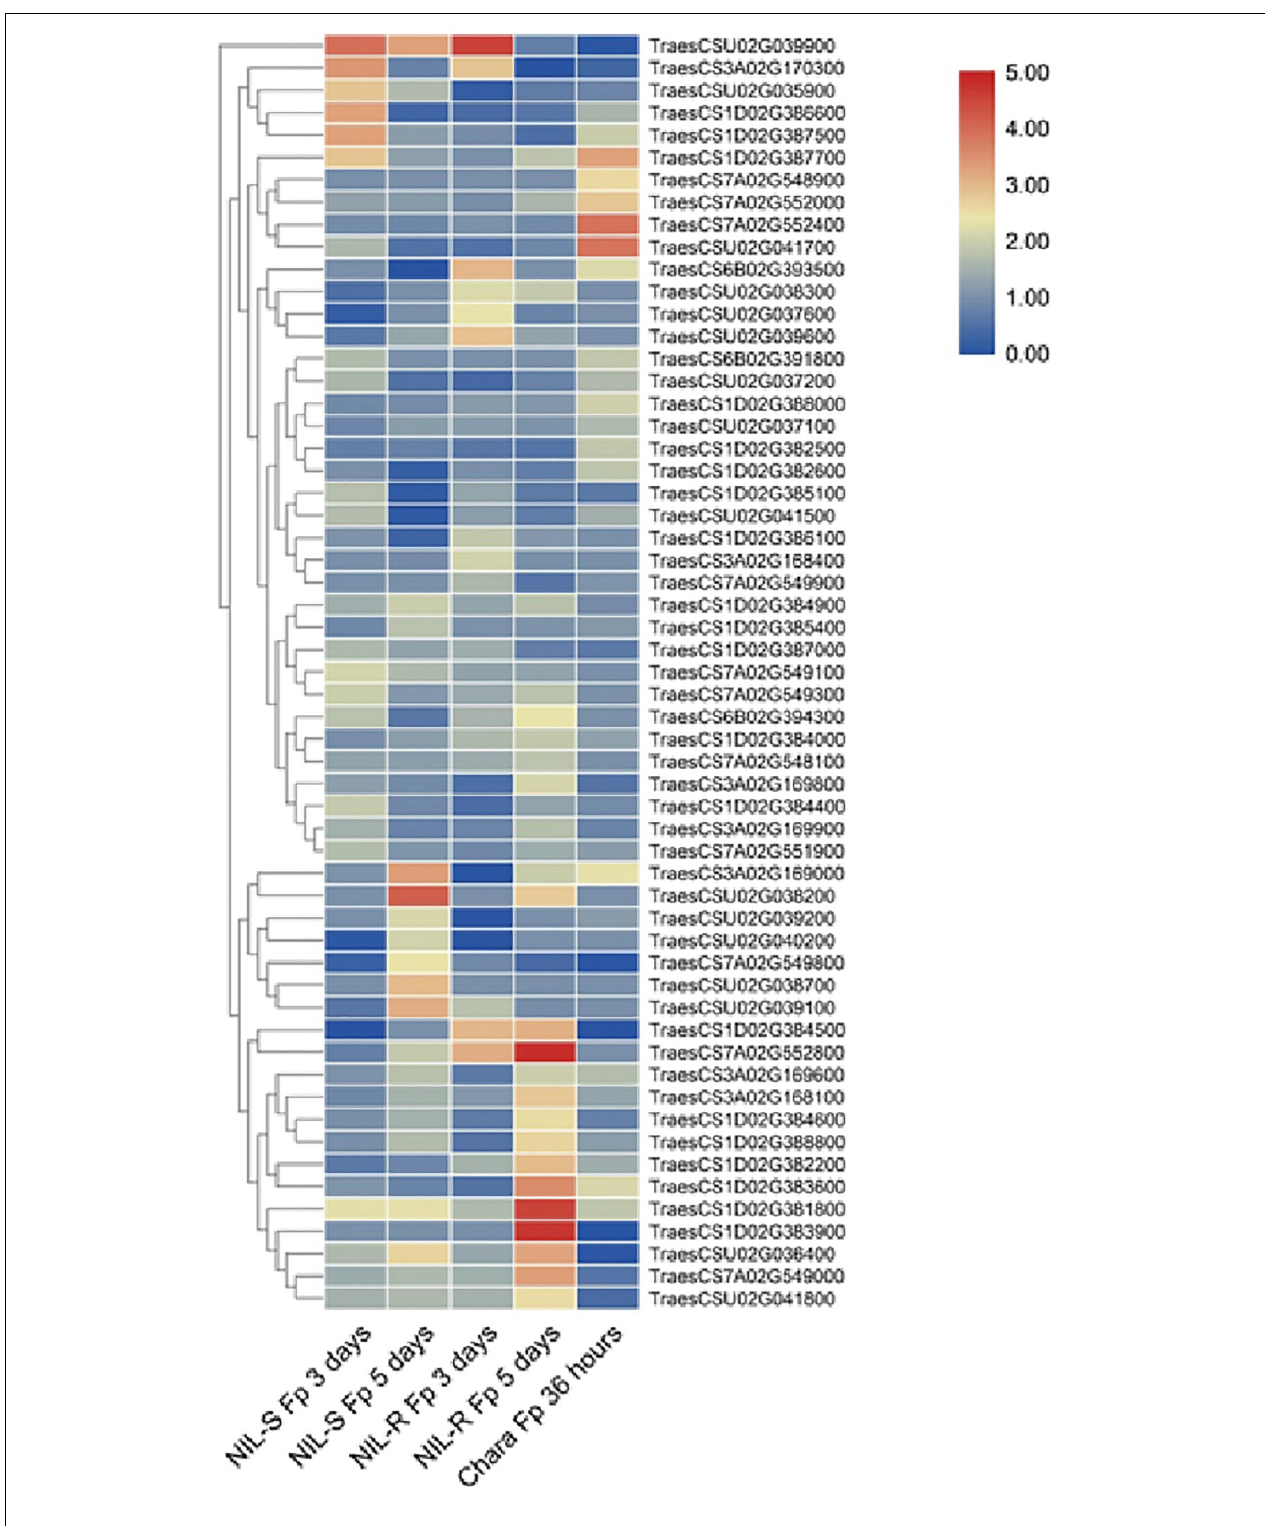
FIGURE 4 | Clustering heatmap for differentially expressed genes infected by Fusarium spp. compared to those in the mock. S-NIL1-Fp 3 days, susceptible isolines infected by Fusarium spp. after 3 days; S-NIL1-Fp 5 days, susceptible isolines infected by Fusarium spp. after 5 days; R-NIL1-Fp 3 days, resistant isolines infected by Fusarium spp. after 3 days; R-NIL1-Fp 5 days, resistant isolines infected by Fusarium spp. after 3 days; Chara-Fp 36 h, wheat culture “Chara” infected by Fusarium spp. after 36 h.